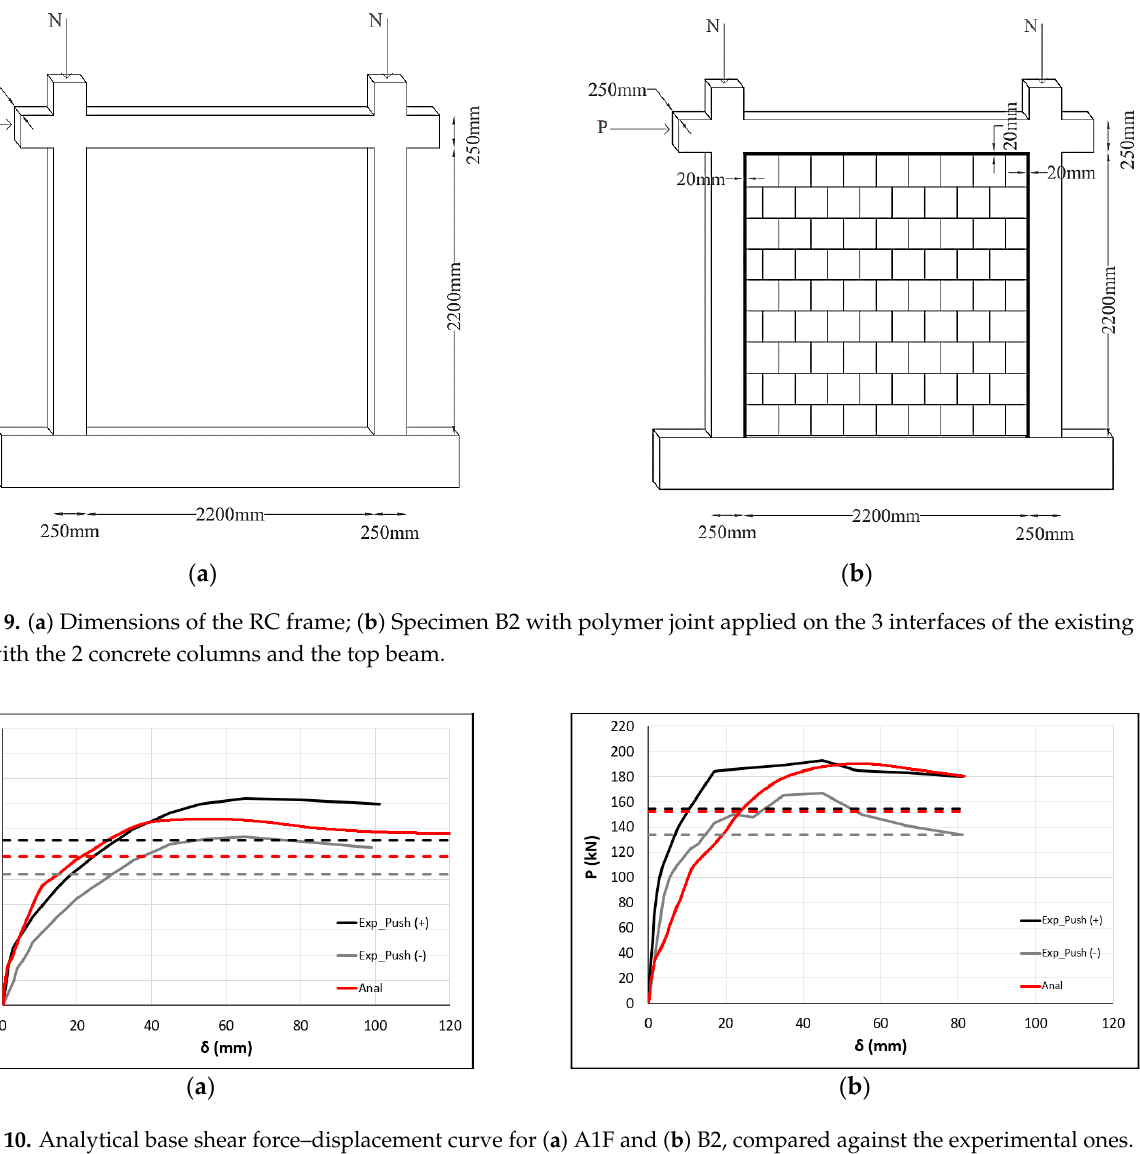
Figure 10. Analytical base shear force–displacement curve for ( a ) A1F and ( b ) B2, compared against the experimental ones.